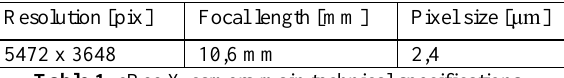
Table 1 . eBee X camera main technical specifications.